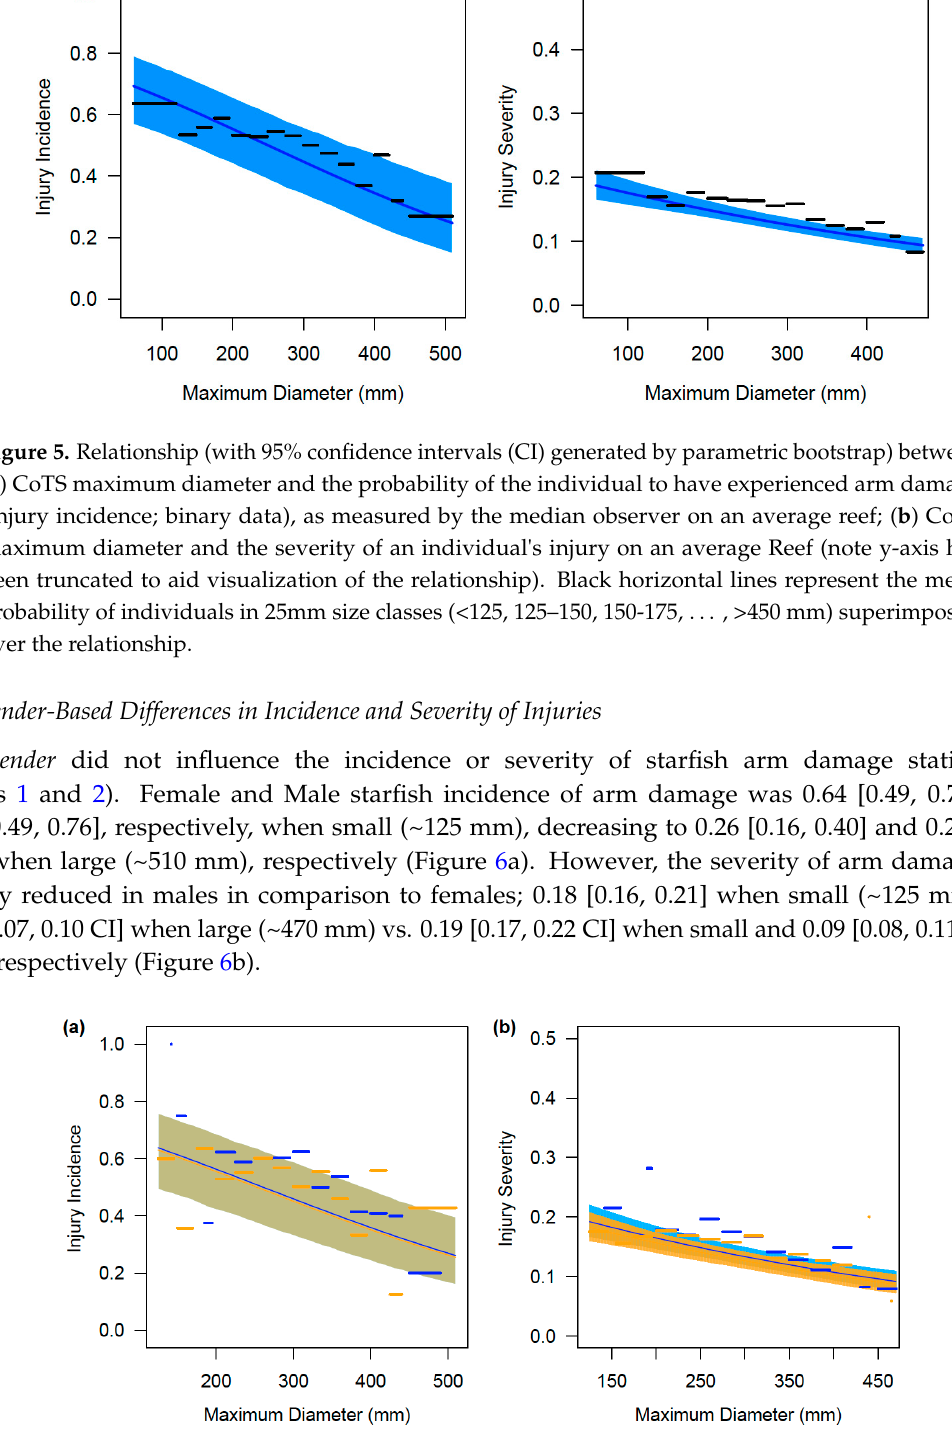
Figure 6. Relationships (with 95% confidence intervals (CI) generated by parametric bootstrap) between female (blue) and male (orange) CoTS maximum diameter and injury ( a ) incidence (arm damage as measured by the median observer on an average reef; binary data) and ( b ) severity on an average reef. Horizontal lines represent the mean probability of female (blue) and male (orange) individuals in 25 mm size classes (<125, 125–150, 150-175, …, >450 mm) superimposed over the relationship. Note that the y-axis has been truncated to aid visualization of the relationship for severity.